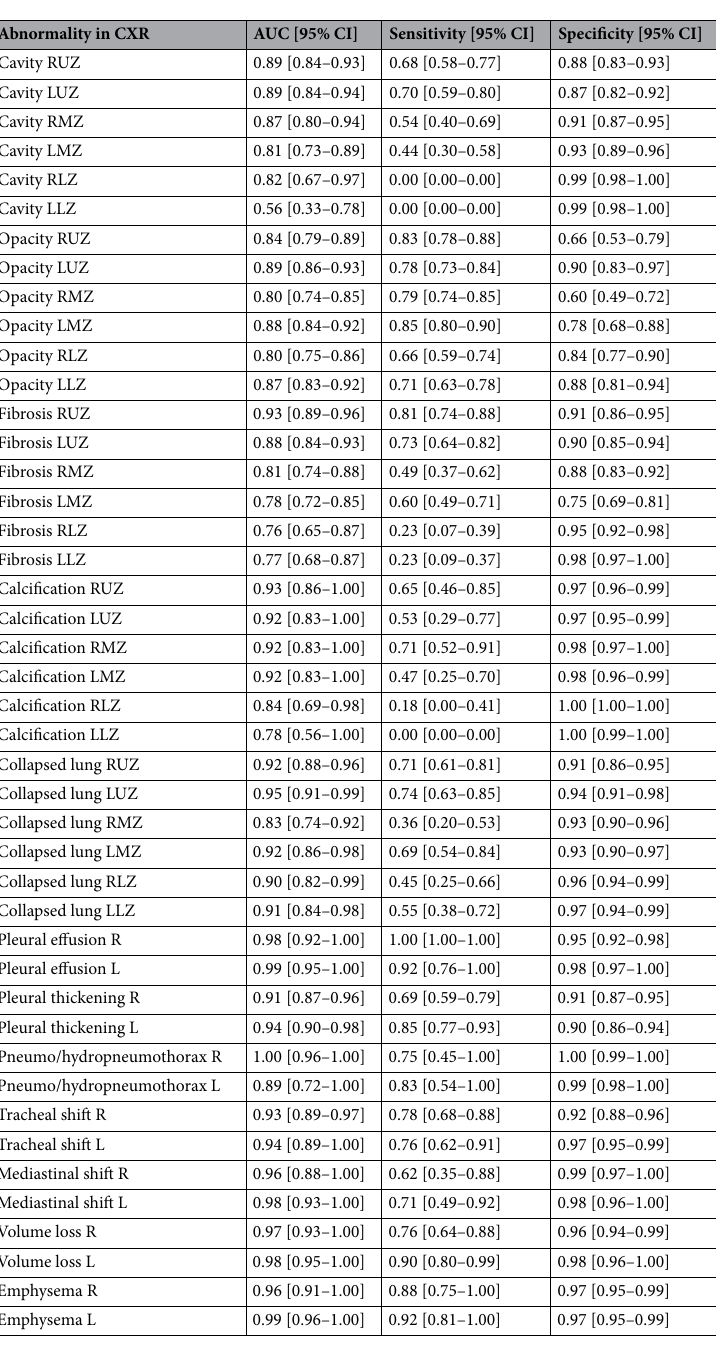
Table 4. Estimates of diagnostic metrics of lung zone wise abnormalities in EfficientNetB4 model. 95% CI for AUC calculated using Hanley & McNeil method. 95% CI for sensitivity and specificity calculated using Wilson Score method. AUC area under the receiver operating characteristic, RUZ right upper zone, RMZ right mid zone, RLZ right lower zone, LUZ left upper zone, LMZ left mid zone, LLZ left lower zone, R right lung, L left lung, CI confidence